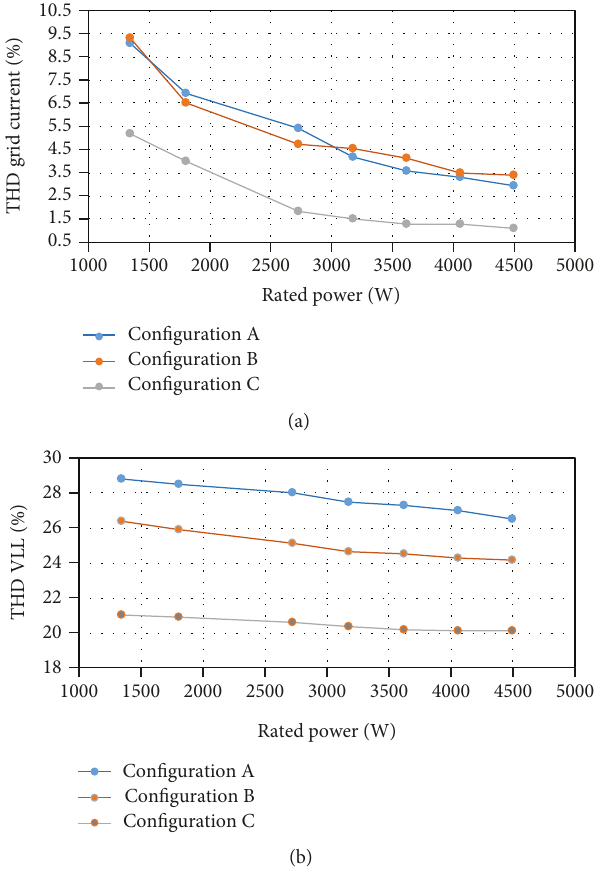
Figure 11: (a) Comparison according to the THD of the grid current. (b) Comparison according to the THD of the line-line voltages.